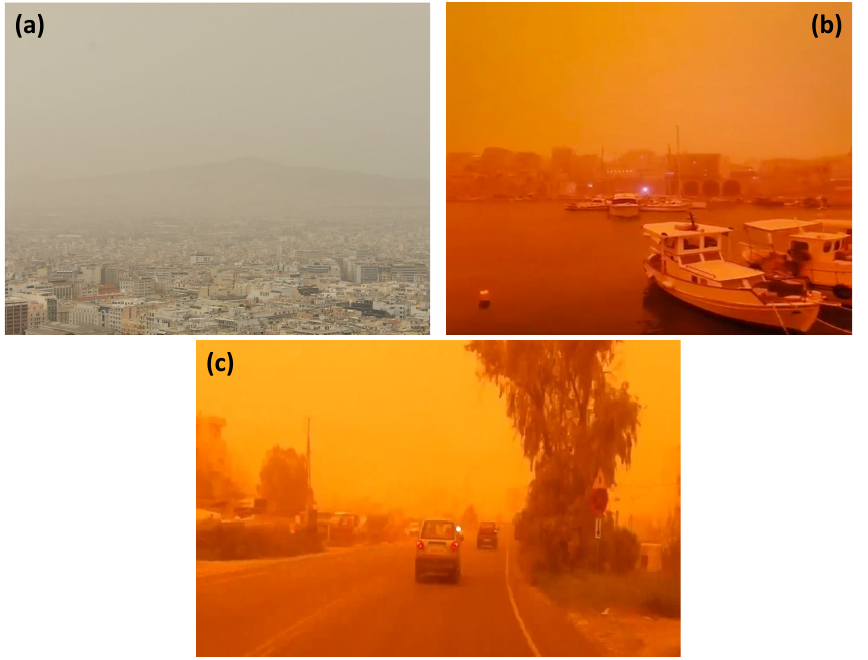
Figure 4. Pictures illustrating the desert dust outbreak that happened on 22–23 March 2018 over Greece. ( a ): Credit Greek Reporter (https://greece.greekreporter.com/2018/03/26/athens-acropolis- covered-in-african-dust-photos/ accessed on 10 April 2022). ( b ): Credit The Sun (https://www. thesun.co.uk/news/5886355/crete-orange-dust-sahara-desert-winds-africa-greek-island/ accessed on 10 April 2022). ( c ): Credit The Watchers (https://watchers.news/2018/03/23/severe-dust-storm- hits-crete-greece/ accessed on 10 April